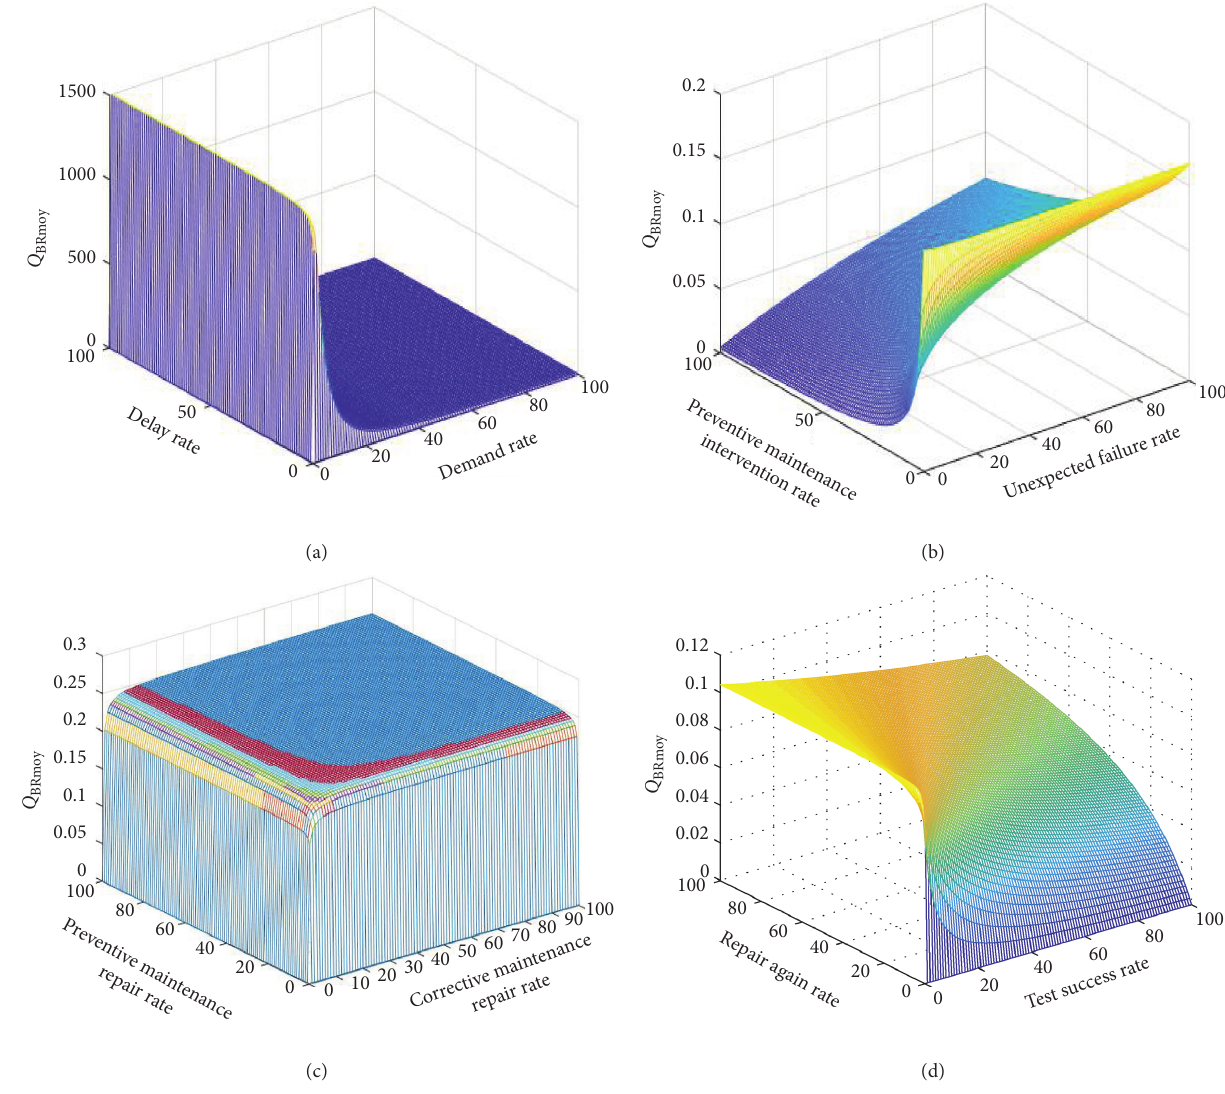
Figure 12: Good repair quality. (a) Variation of demand and delay rates. (b) Rate variation of unexpected failure and maintenance interventions. (c) Repair rate variation for corrective and preventive maintenance. (d) Test rate variation (repair again or